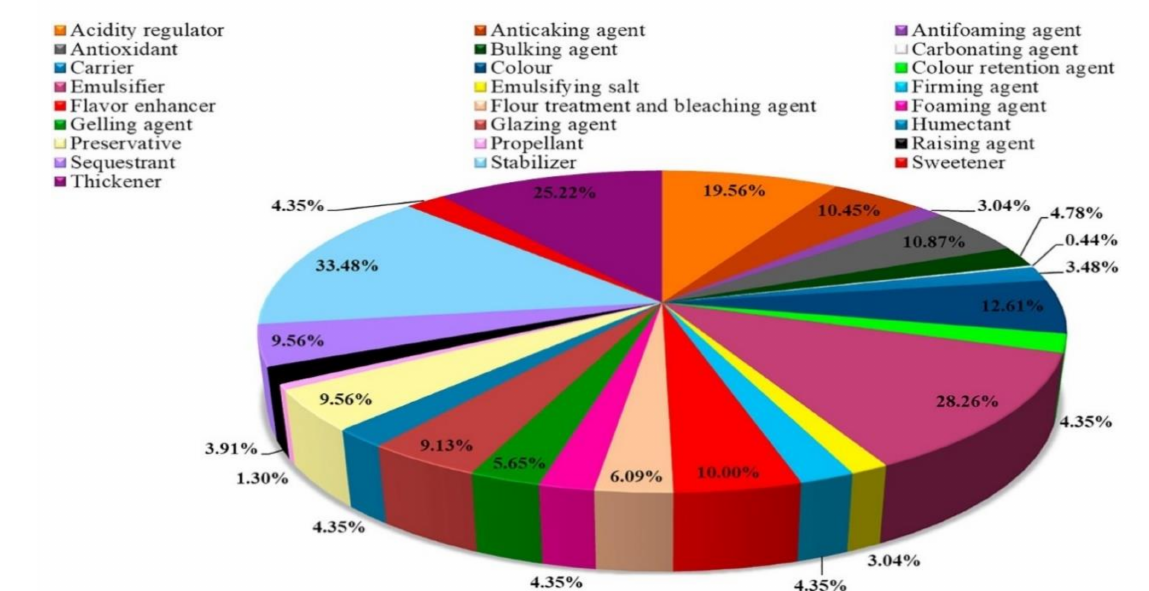
Figure 2. Percentual relationship of each class of the food additives used in food industries [32]. Copyrights